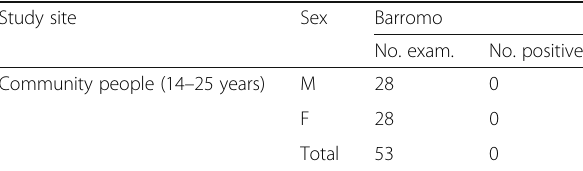
Table 1 Original version of Table 1 as published on 15 August 2017